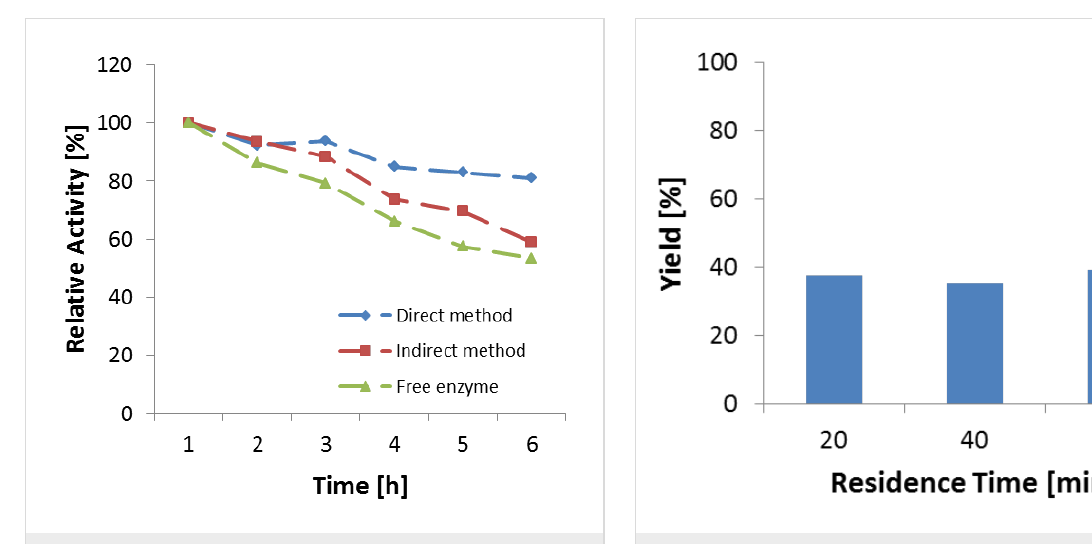
Figure 1: Activity loss of TA immobilized by two different methods and as a free enzyme at 80 °C. Reproduced with permission from Elsevier [48].